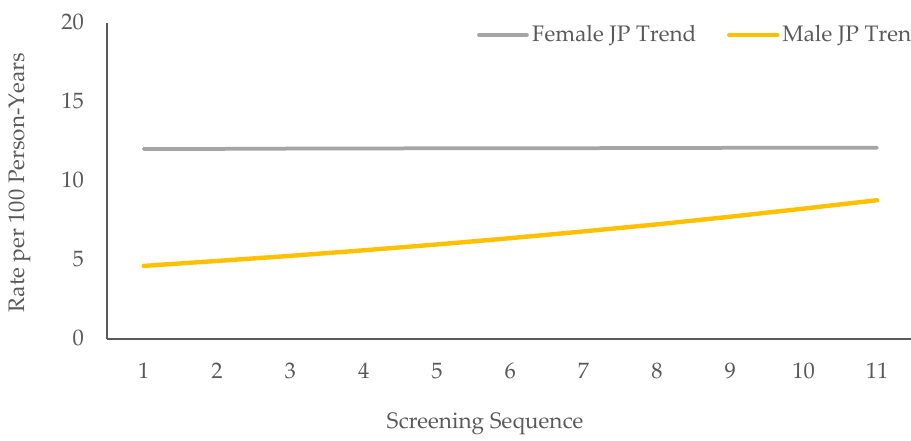
Figure 1. Joinpoint (JP) trend analyses of incidence rates over the 11 follow-up screenings. Table 4. Annual percentage change (APC) in incidence rates over time.